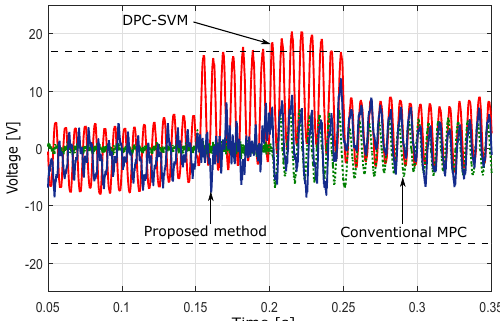
Figure 10. Performance of the neutral-point voltage u z .